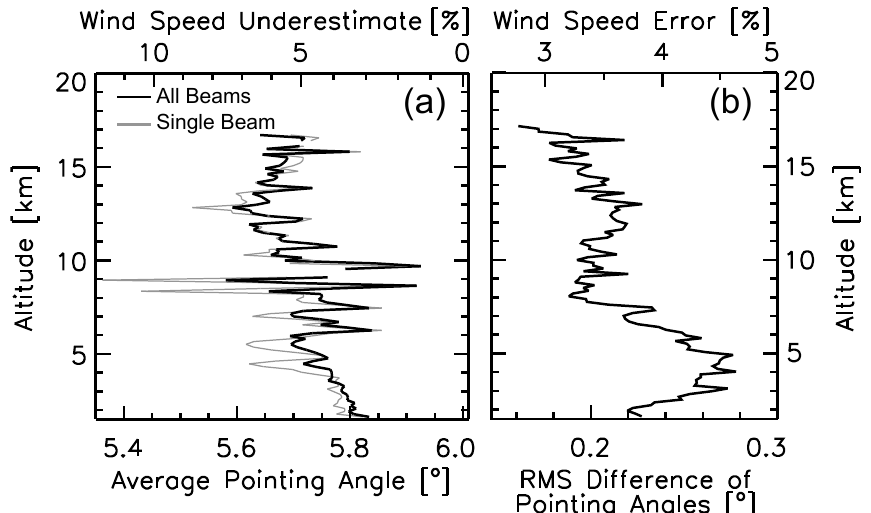
Figure 8. (a) Average effective pointing angles for 6 ◦ beams, calculated across the 8 weeks of special operation. Effective pointing angles using one (grey curve), and all (black curve), 4.2 ◦ beams are shown. The top axis gives the corresponding underestimate in wind speed. (b) RMS difference in effective pointing angles derived using one and four 4.2 ◦ beam echo powers, calculated over the 8 weeks. The top axis gives the corresponding uncertainty in winds corrected with the one-beam method.